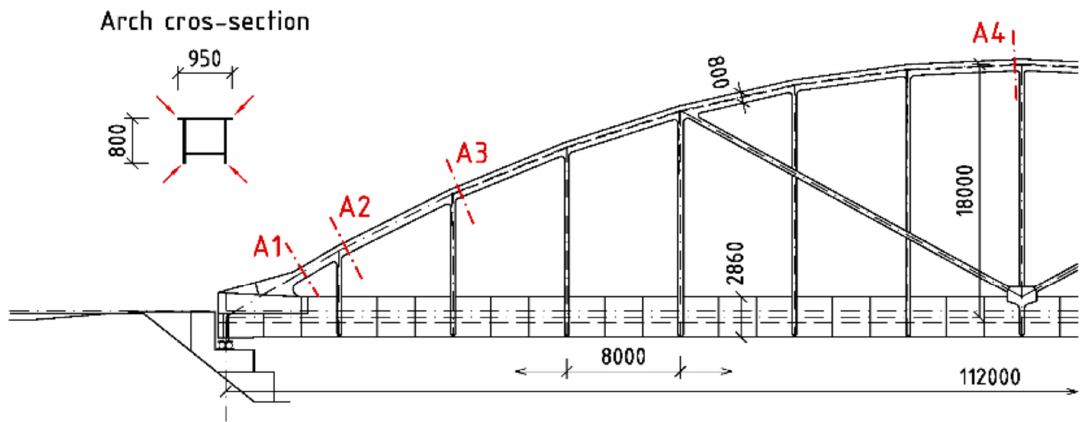
Figure 9. Side view of the bridge with the designation of the four selected arch cross-sections, where the stresses were analysed (dimensions in millimetres). Table 1. Maximum corner stresses in the selected arch